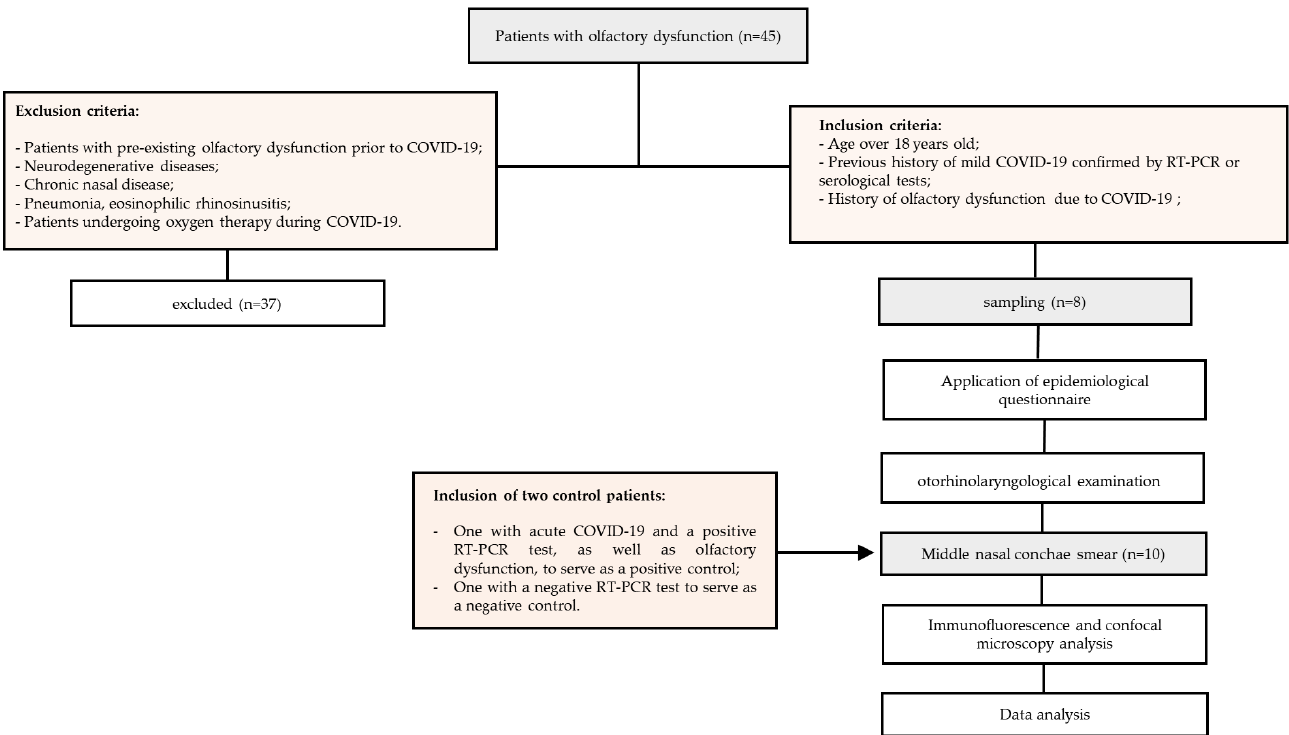
Figure 1. Flowchart illustrating the study’s design and the total number of individuals included.